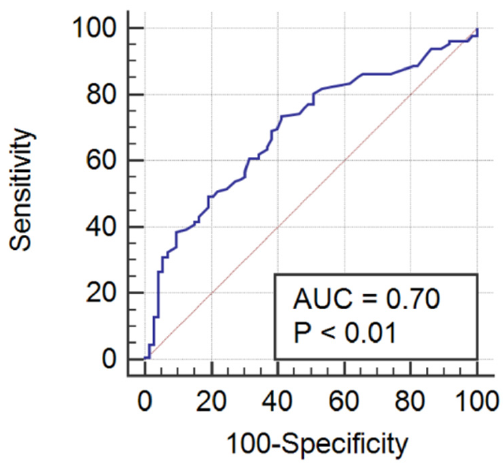
Figure 2. The receiving operating characteristic curve of INR in prediction of sepsis on admission to ICU. ICU—intensive care unit, INR—international normalized ratio.